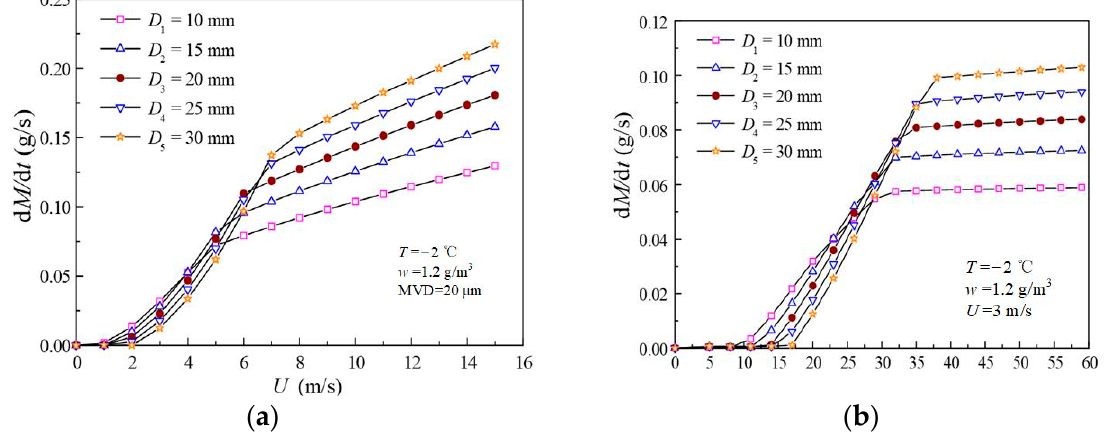
Figure 3. The icing rates of five conductors (L = 1 m) with different diameters under different U and MVD: ( a ) Different wind speeds U;( b ) Different MVD